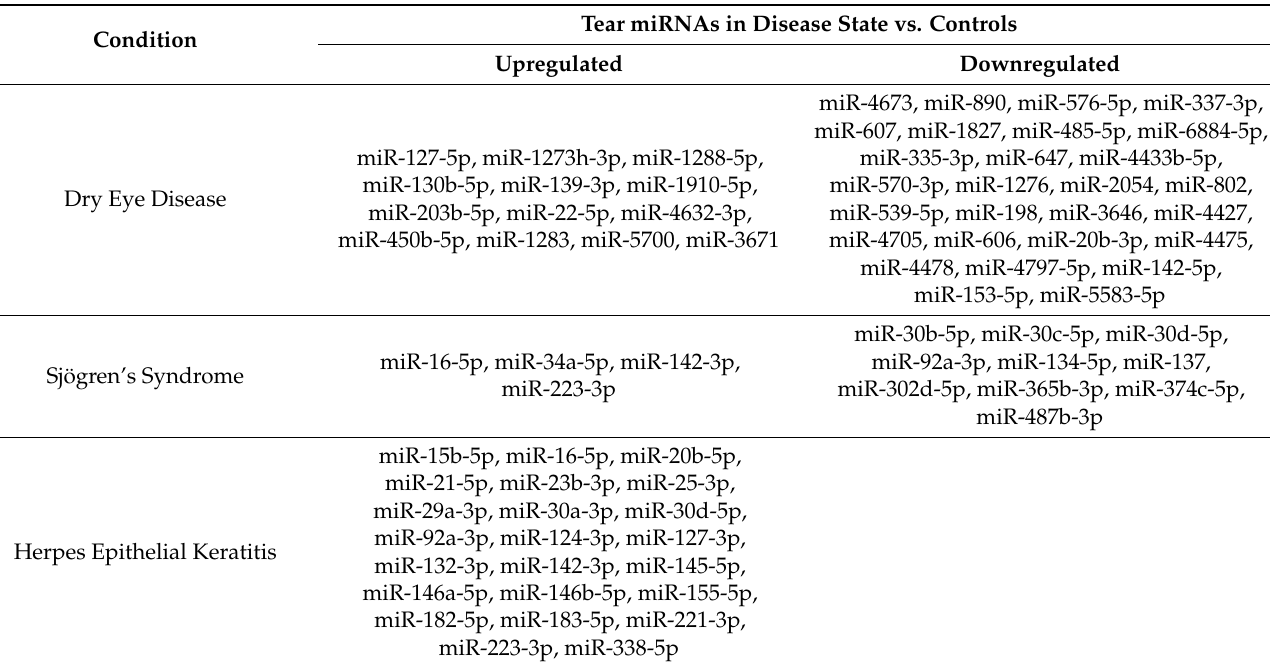
Table 2. Up and down-regulated tear microRNAs reported as potential biomarkers. Tear miRNAs in Disease State vs. Condition